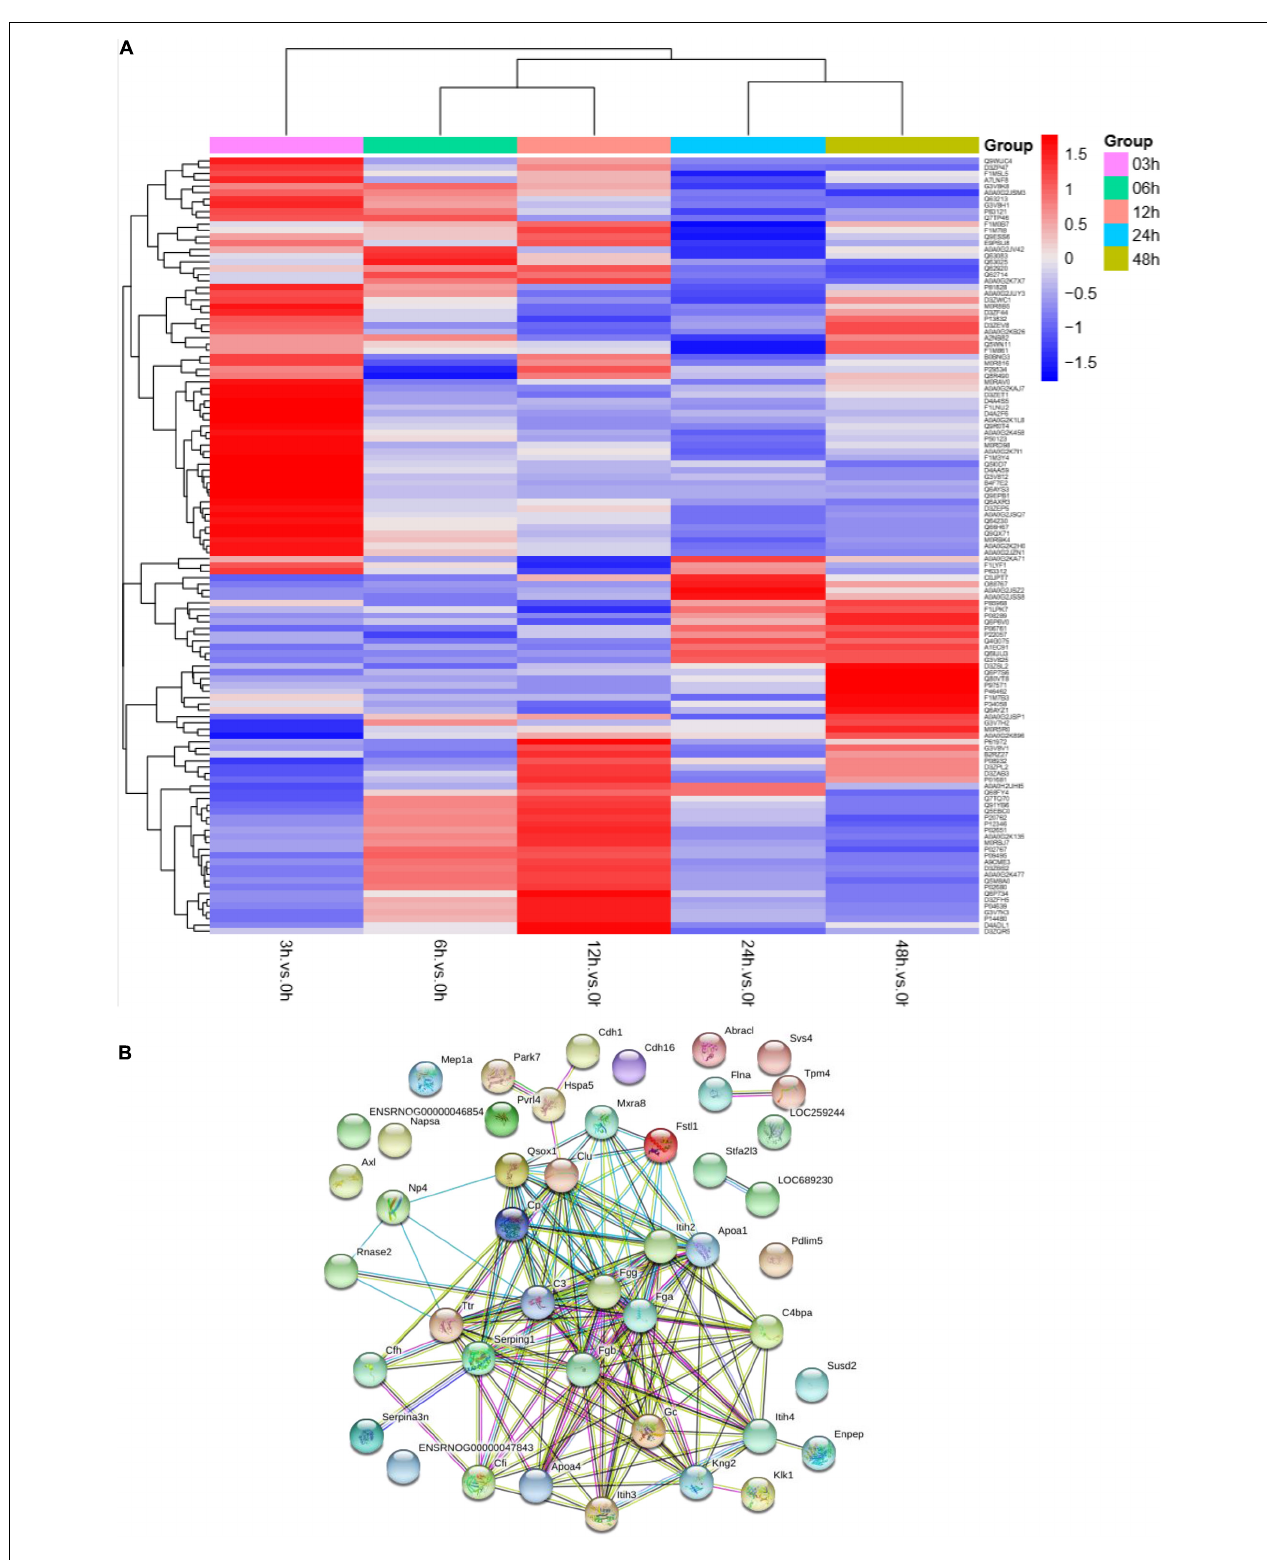
FIGURE 3 | The protein profile changed during sepsis-AKI. (A) Heatmap showed the differential expression protein in urine at the indicated time (3, 6, 12, 24, and 48 h) compared with 0 h analyzed by one-way ANOVA. The fold change was defined as ≥ 1.5 or ≤ 0.5. (B) PPI networks of the differentially expressed proteins were constructed based on the STRING database web